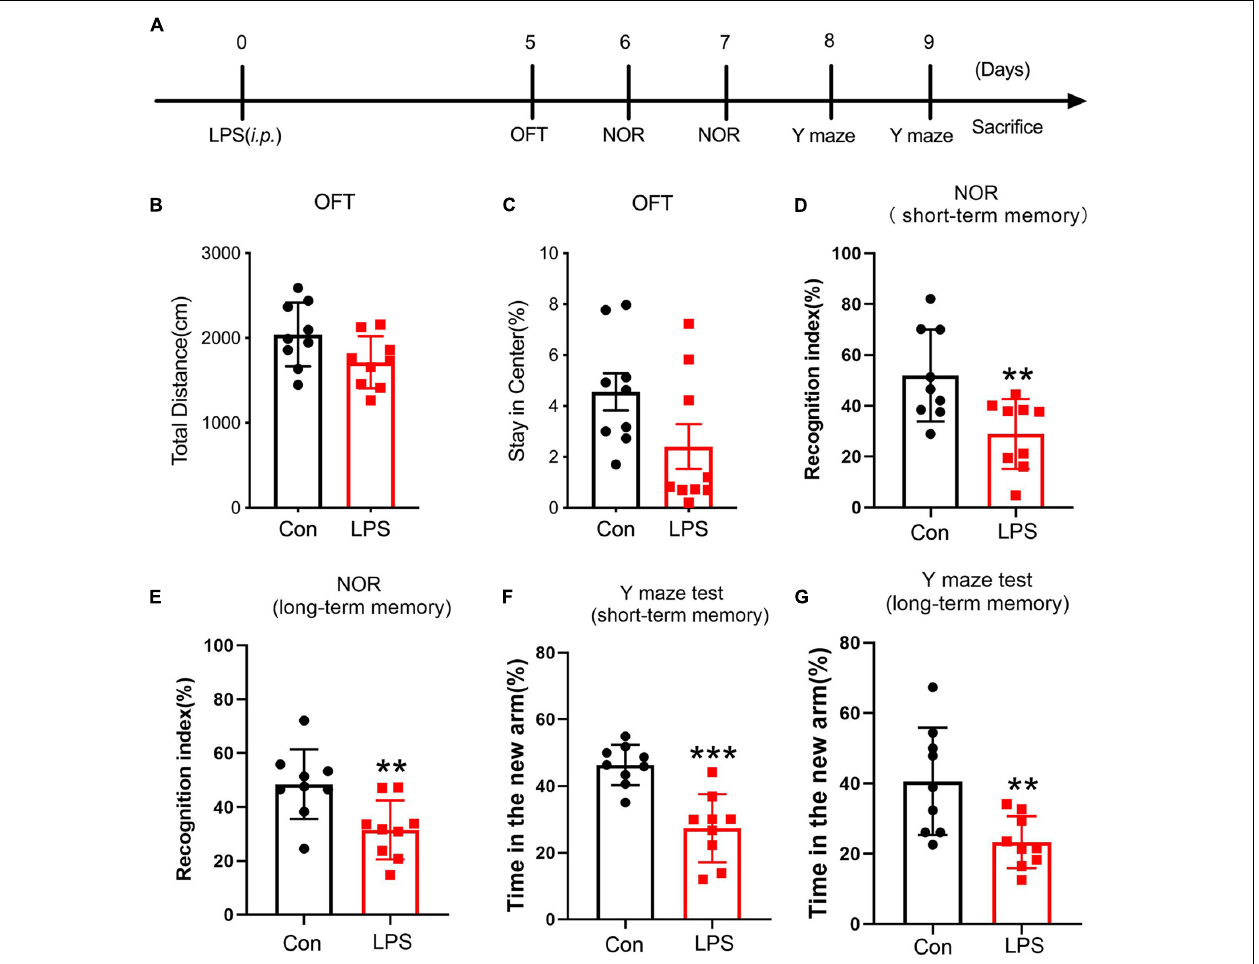
FIGURE 1 | Behavioral tests after the establishment of the sepsis-associated encephalopathy mouse model. (A) Timeline of behavioral tests after administration of lipopolysaccharide. (B,C) The total distance and the time spent in the center field of the open field test ( n = 9/group). (D,E) The recognition index of short-term or long-term memory tasks in the novel object recognition test ( n = 9/group). (F,G) The percentage of time mice stay in the novel arm in the short-term or long-term memory task in the Y maze test ( n = 9/group). Data are expressed as mean ± SEM. ** p < 0.01, *** p <